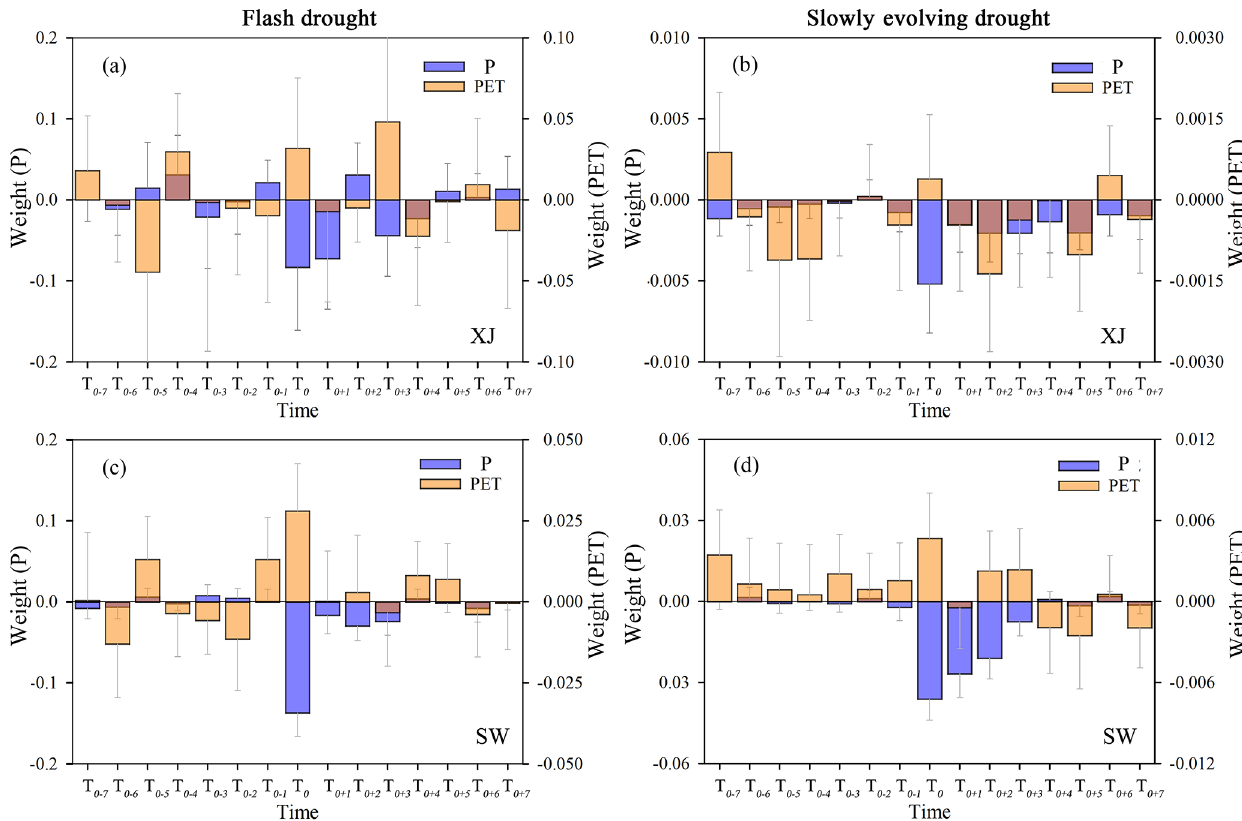
Figure 12. The weights of P (blue bar) and PET (yellow bar) for flash droughts and slowly evolving droughts based on the MLR method in adjacent weeks to drought onset in the XJ and SW regions. T 0 − 1 denotes 1 week prior to the onset time, while T 0 + 1 represent 1 week after the onset